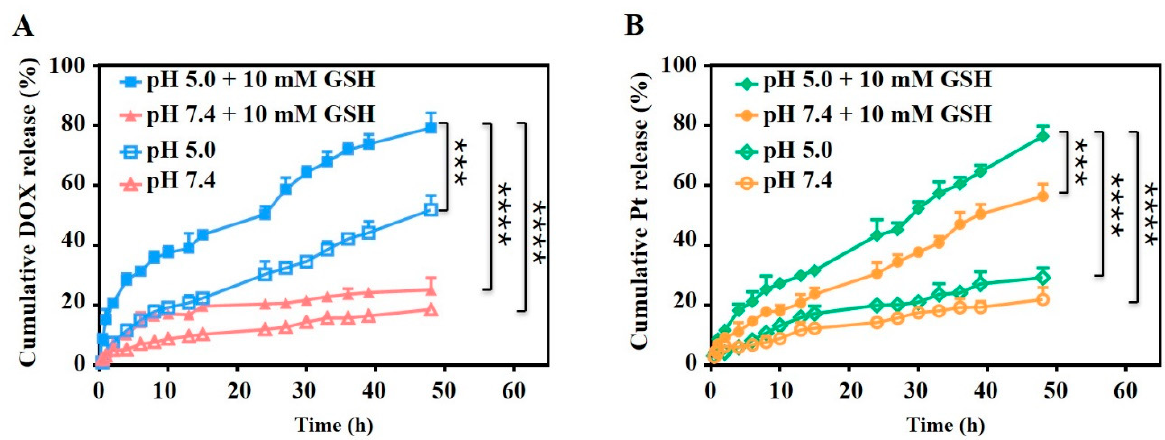
Figure 4. Drugs release profiles. ( A ) DOX and ( B ) Pt release behaviors from oDex-g-Pt+DOX NPs (platinum plus DOX conjugated oxidized dextran nanoparticles) at different conditions. Data points represent mean ± s.d. ( n = 3) from three independent experiments. Statistical significance was calculated via one-way ANOVA analysis with a Tukey post-hoc test. *** p < 0.001, **** p < 0.0001.